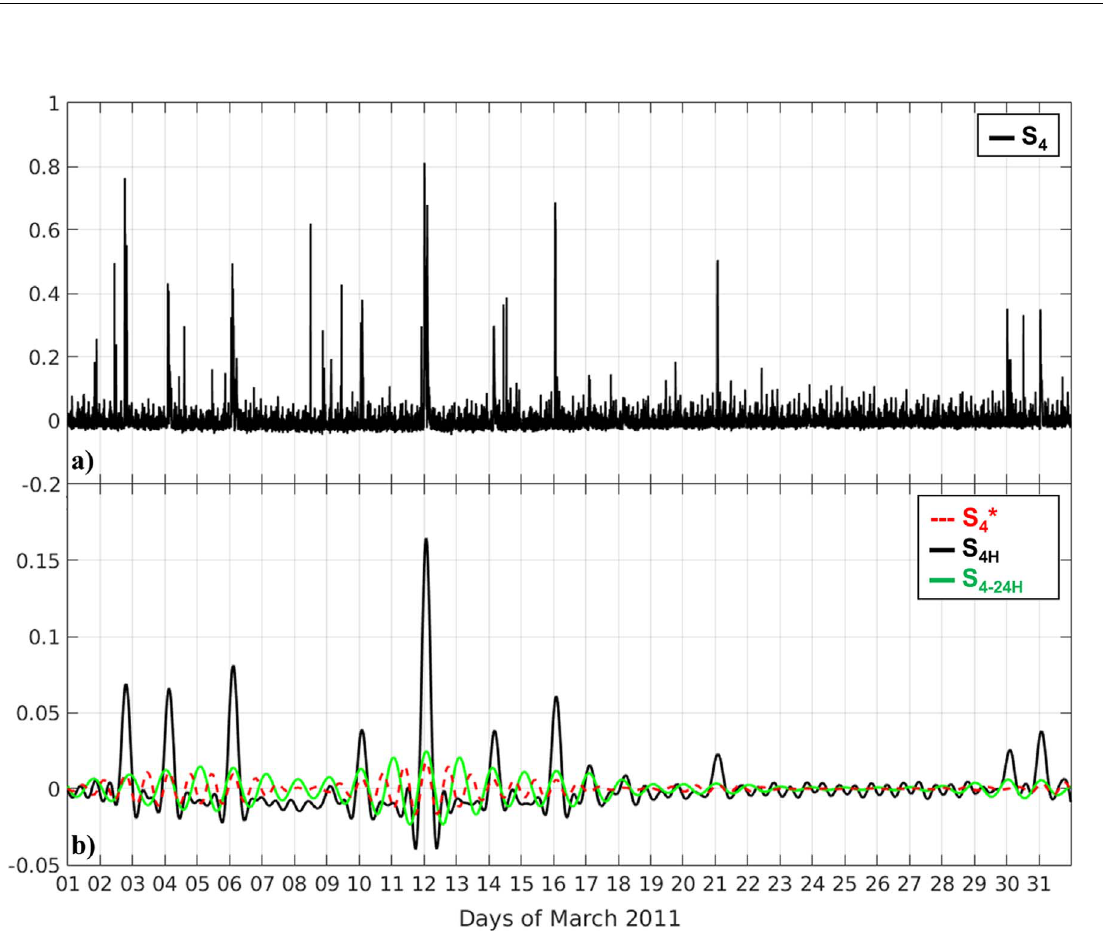
Fig. 4. (a) Same as Figure 2a. (b) Time pro fi le of S 4H (black solid line), S 4-24H (green solid line), being the intrinsic mode component having 1-day period, and S 4 * (red dashed